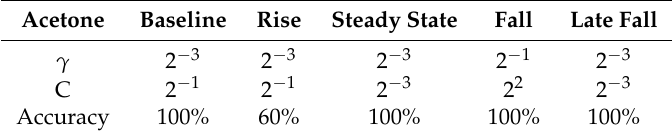
Table 6. Cross validation results for ethanol.